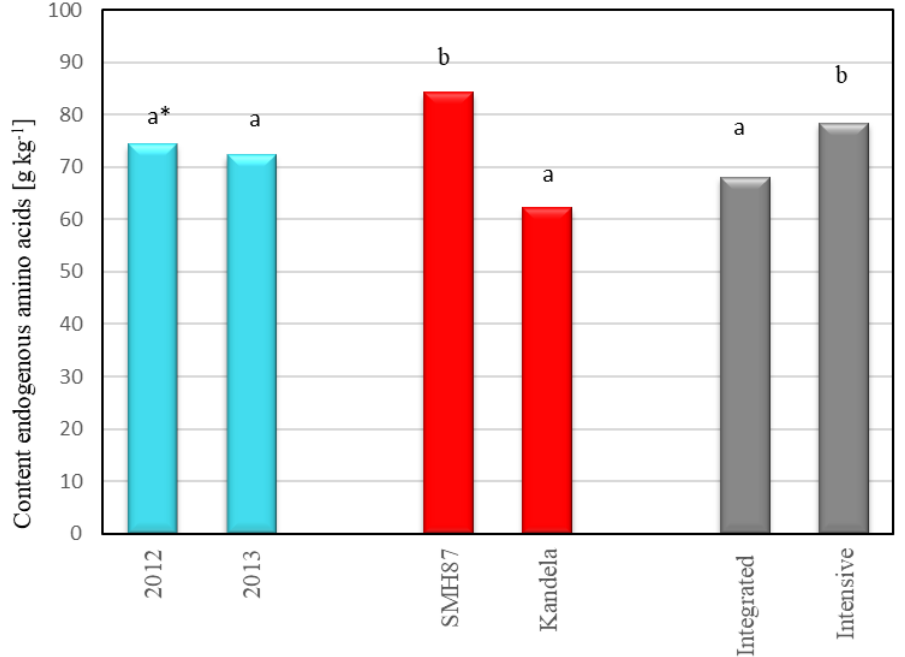
Figure 4. Content of endogenous amino acids in wheat grain depending on the year of harvest, cultivar and production technology. * Different letters (a, b) are significantly different (α = 0.05).